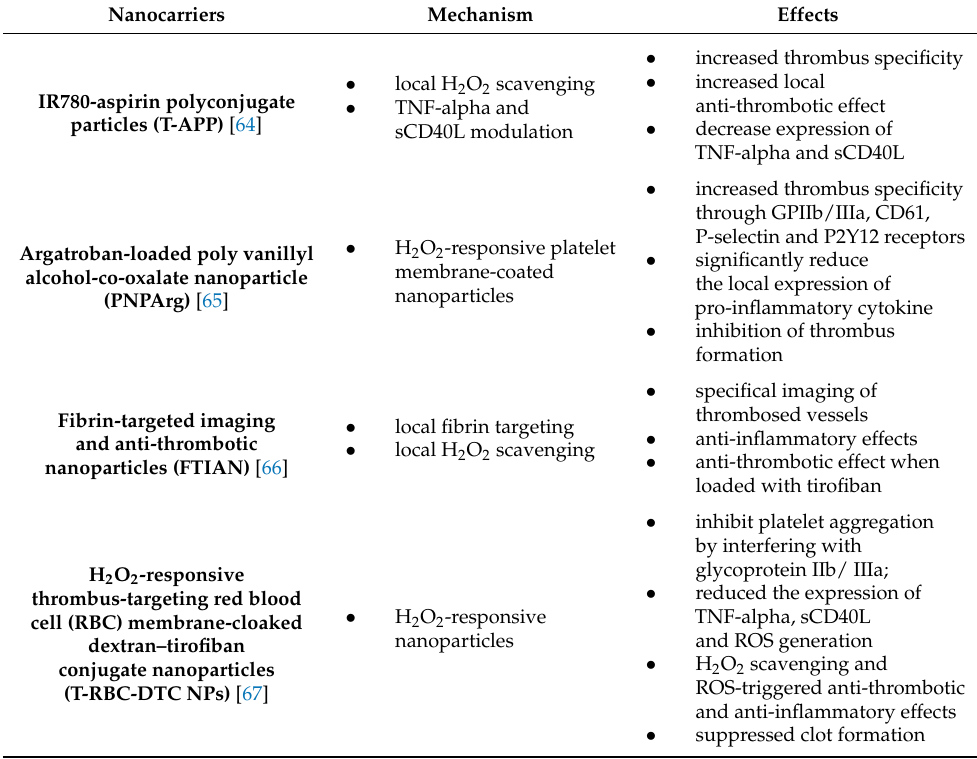
Table 2. Nanocarriers for management of arterial